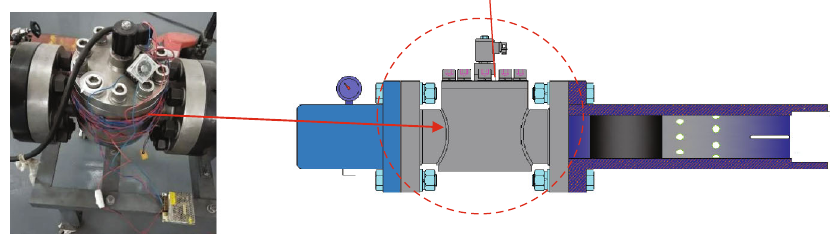
Figure 8: Experimental components of impact energy